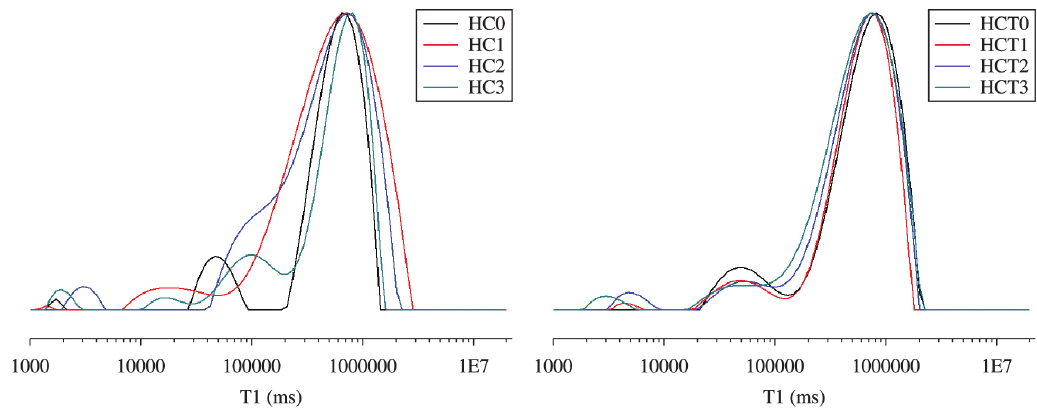
Figure 2. Domains curves distribution for the samples prepared with chloroform (HC) and chloroform/toluene